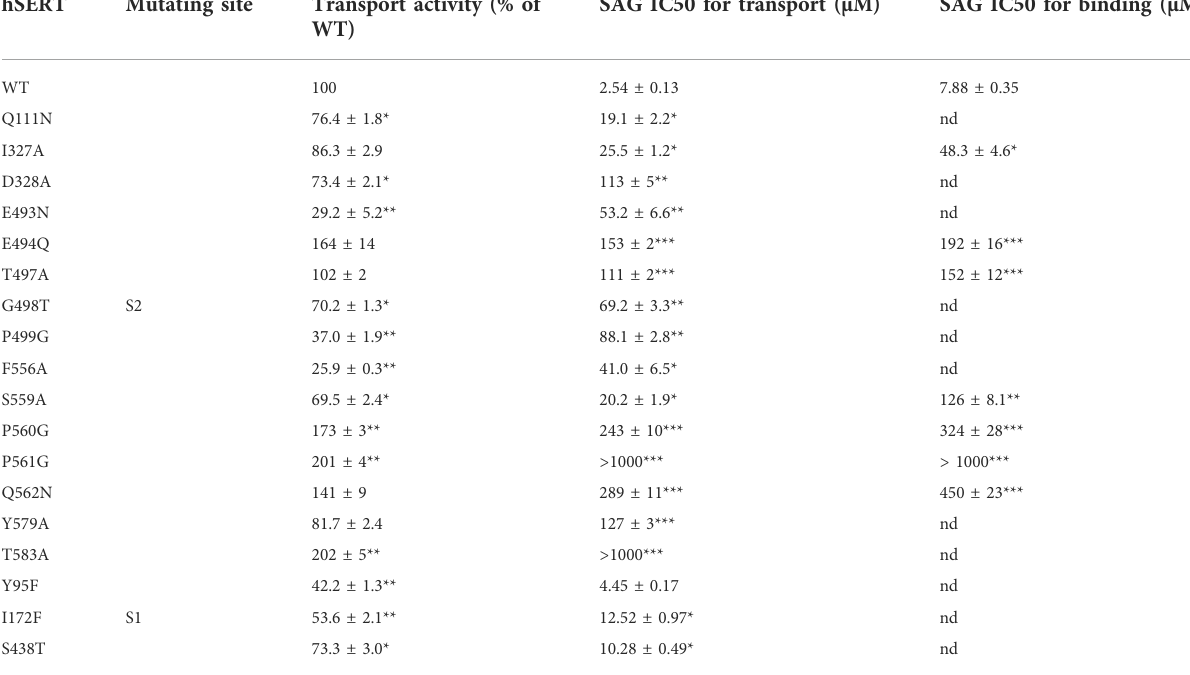
TABLE1InhibitionpotencyofSAGforWTandmutantsofhSERT.APP + transportorASP + bindingwasperformedonintactordigitonin-permeabilized HeLa cells transiently expressing WT or allosteric and orthosteric mutants of hSERT as described under “ Materials and methods ” . For APP + transport,cellswereincubatedwith2 μ MAPP + for5 min.SAGwasadded5 minpriortoAPP + toobtainequilibrium.IC50valueswerecalculatedfrom non-linear regression analysis of APP + uptake. The APP + uptake rate without SAG addition for WT-hSERT was 43.32 ± 1.78 mean AFU/min. For ASP + binding, SAG was added in the presence of 25 μ g/ml digitonin 5 min prior to ASP + addition. The permeabilized cells were incubated with 10 μ M ASP + for 5 min. The ASP + binding without SAG addition for WT-hSERT was 20.89 ± 0.46 mean